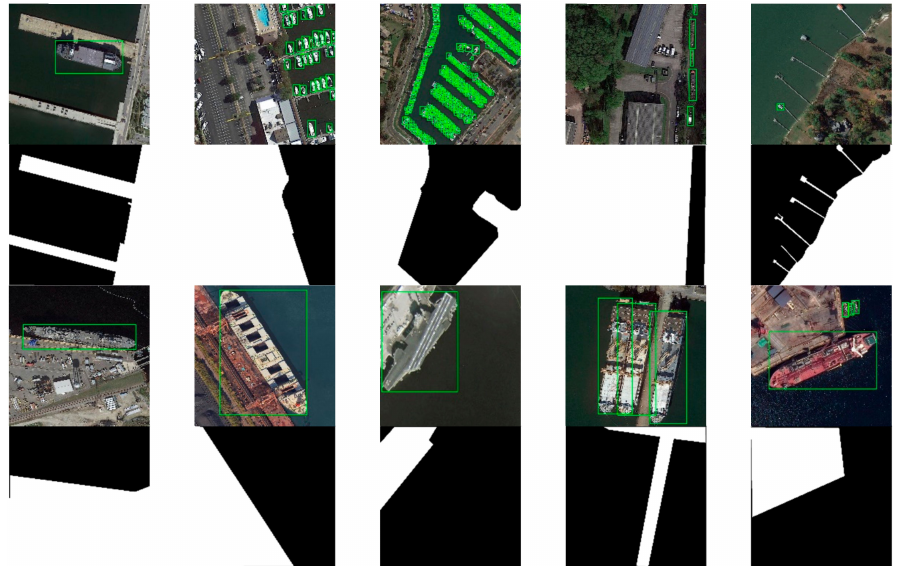
Figure 17. The dataset used in the experiments. The first two row are images in DOTA (training dataset) and their mask labels, the last two rows are images collected from Google Earth and their mask labels in the testing